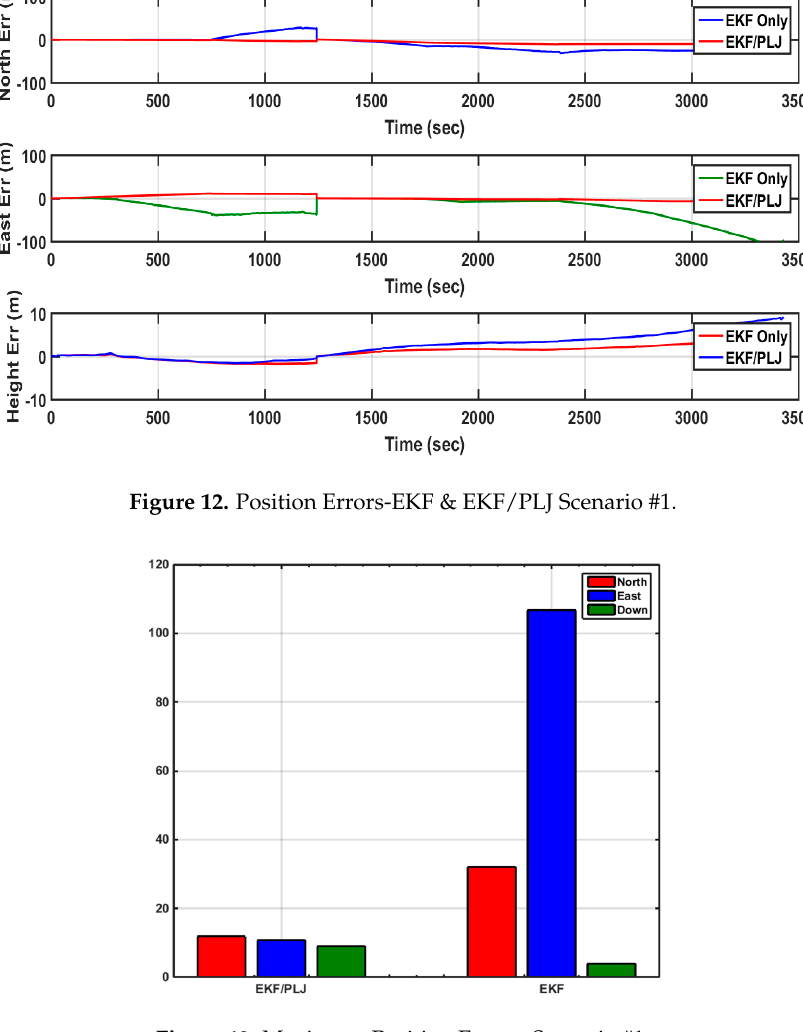
Figure 14. RMS Position Errors—Scenario #1. 4.2. Scenario #2 Scenario #2 is similar to scenario #1, without adding any AGM. Directly from the output trajectory, the difference between both solutions is clear, as shown in Figure 15. The position errors for each method are shown in Figure 16. Figure 15. Trajectories—Scenario #2.